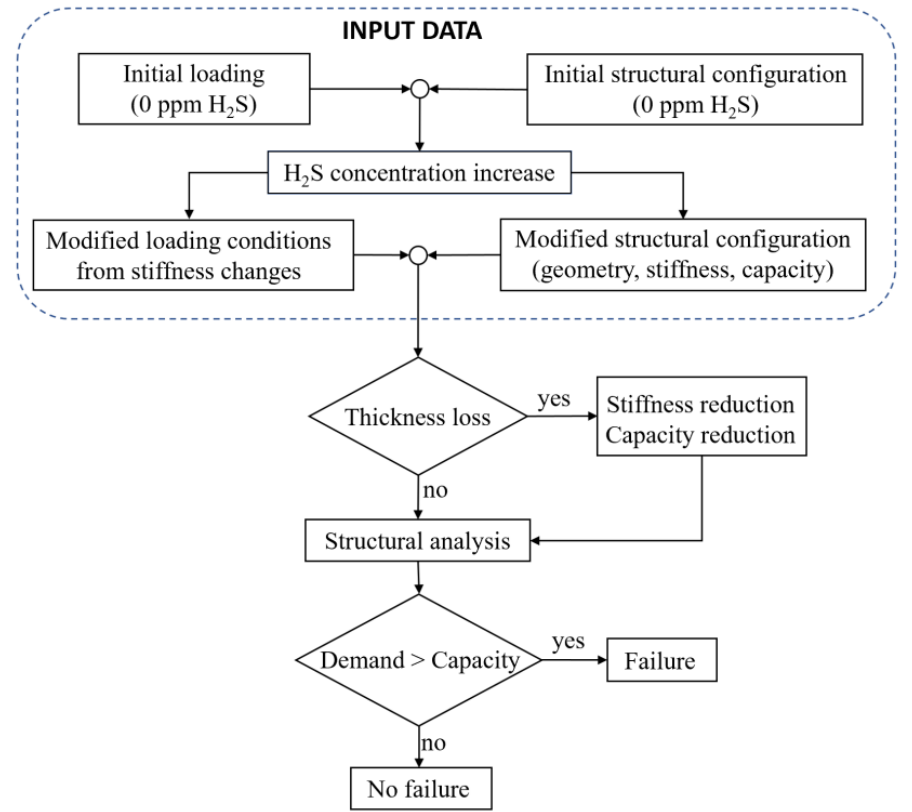
Figure 2. Flowchart of the proposed model for the structural analysis of a reinforced concrete sewer.